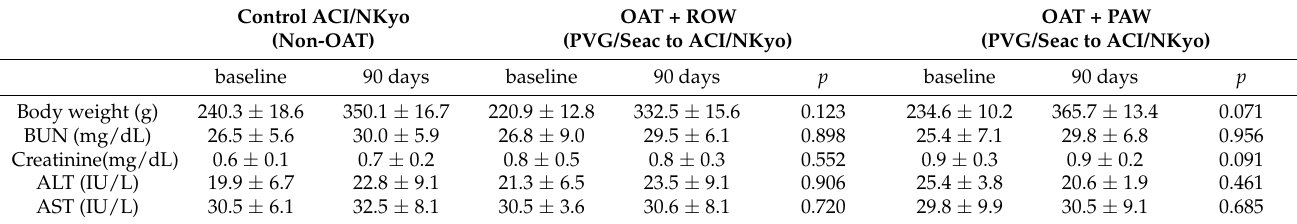
OAT + PAW (PVG/Seac to ACI/NKyo)